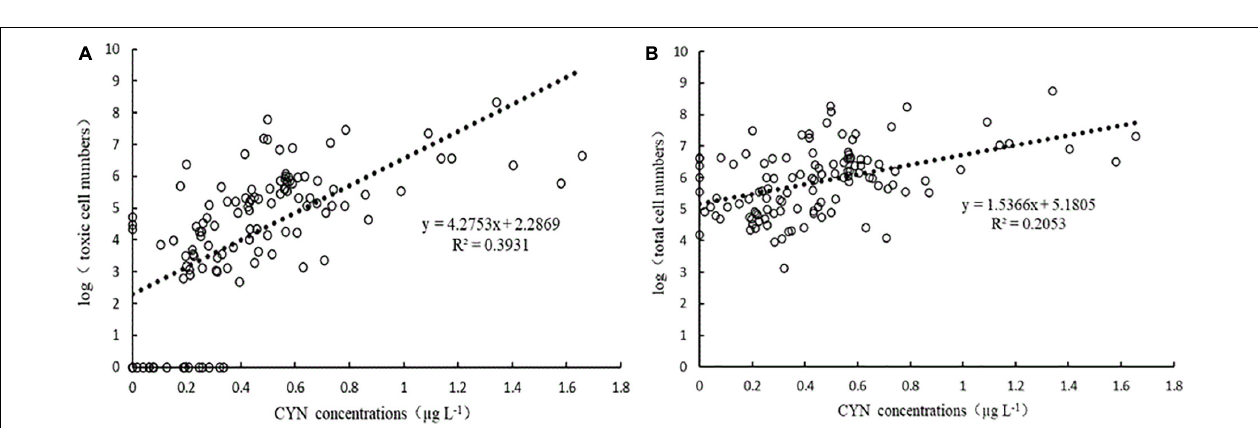
FIGURE 3 | Correlation between CYN concentrations and the log 10 toxic ( cyrJ gene copies, (A) and total ( rpoC1 gene copies, (B) cell numbers of R. raciborskii determined by real-time PCR.